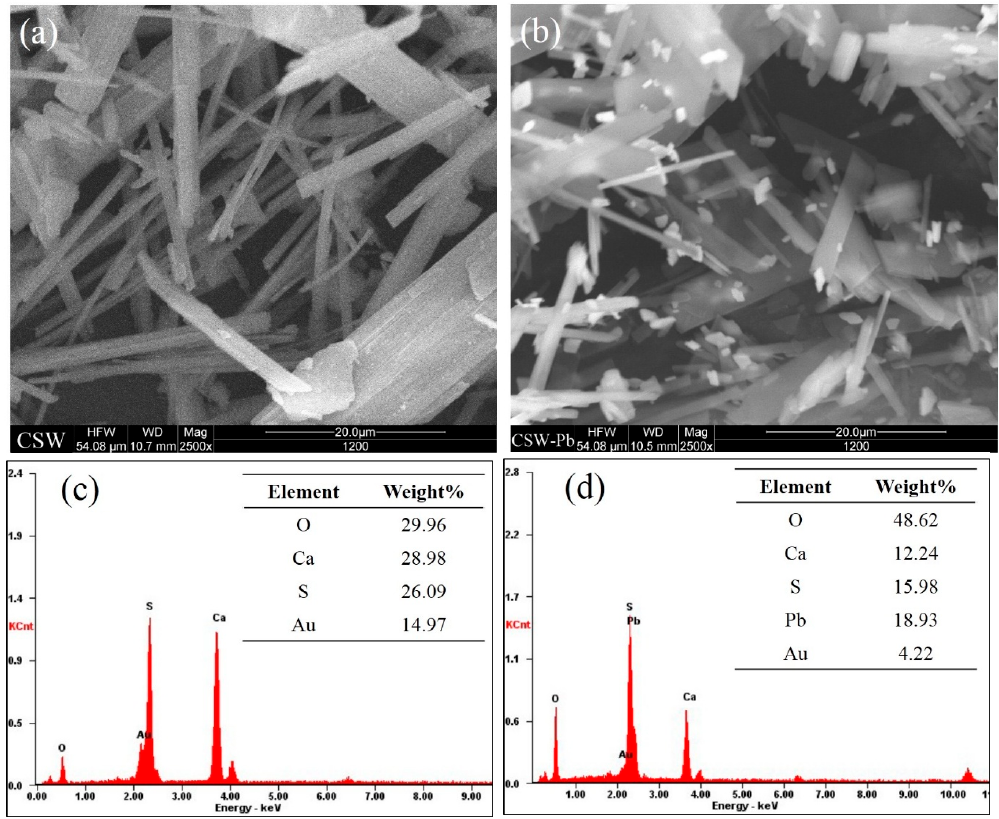
Figure 11. SEM graph and EDS spectra of the particles before and after adsorption: ( a , c ) fresh CSHW; ( b , d ) post adsorption product.